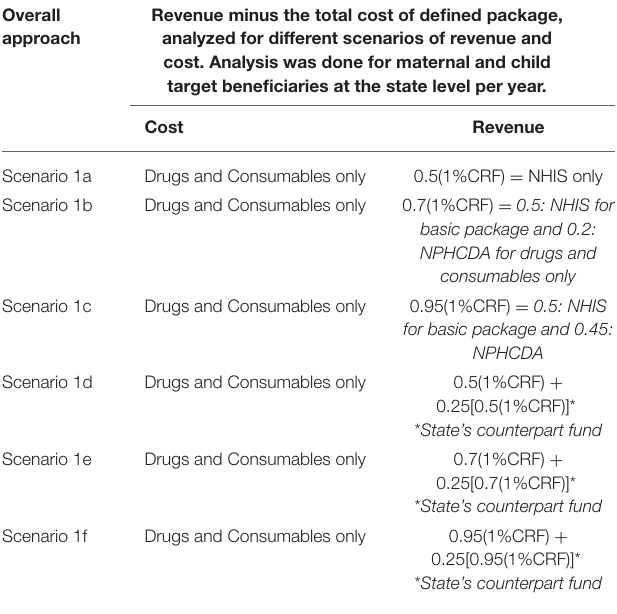
TABLE 4 | Feasibility and gap analysis under scenario